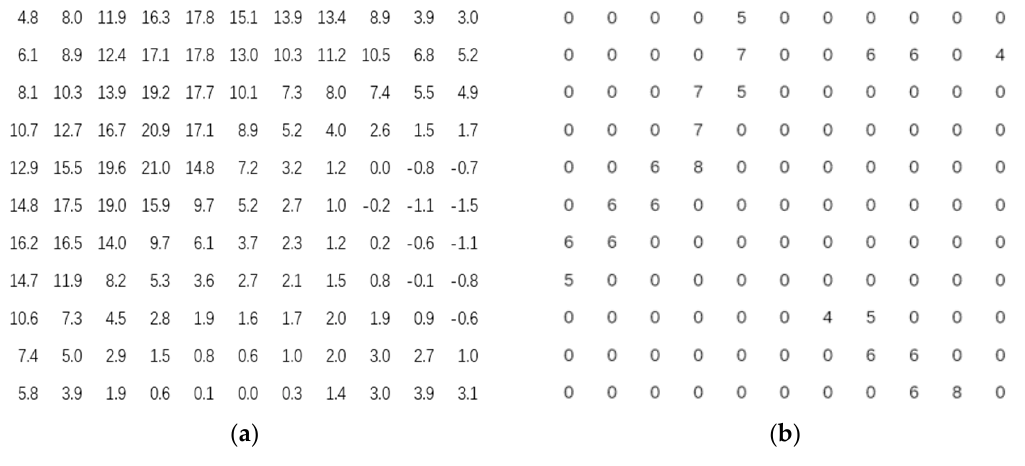
Figure 3. Extraction of the tracing starting points and candidate trough points: ( a ) calculation results of the grid points’ curvature. ( b ) The grid points marked by “8” imply the tracing starting points of the trough line and the other points with N ≠ 0 represent the candidate trough points.